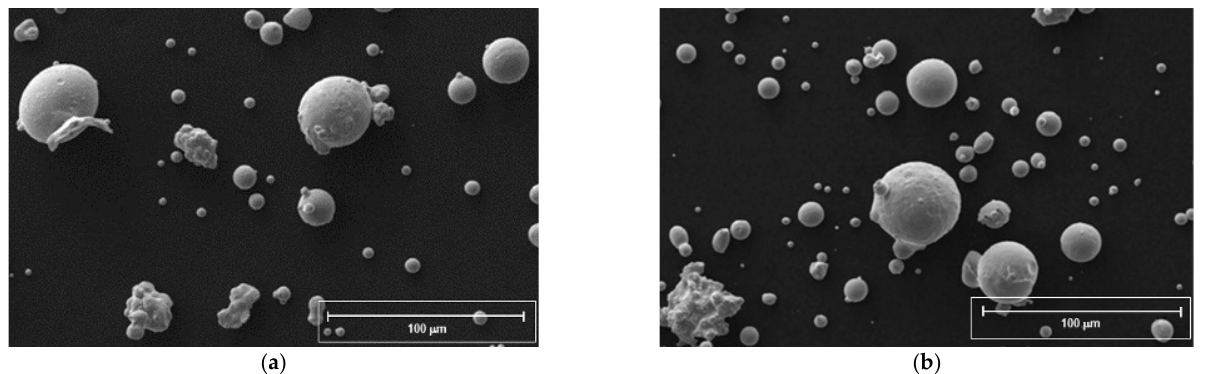
Figure 2. Powder steel morphology of FeSi3 ( a ) and FeSi6.5 ( b ), SEM images.